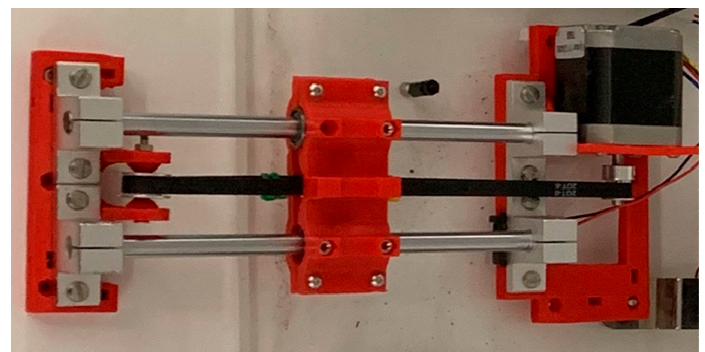
Figure 16. Line chattering module.